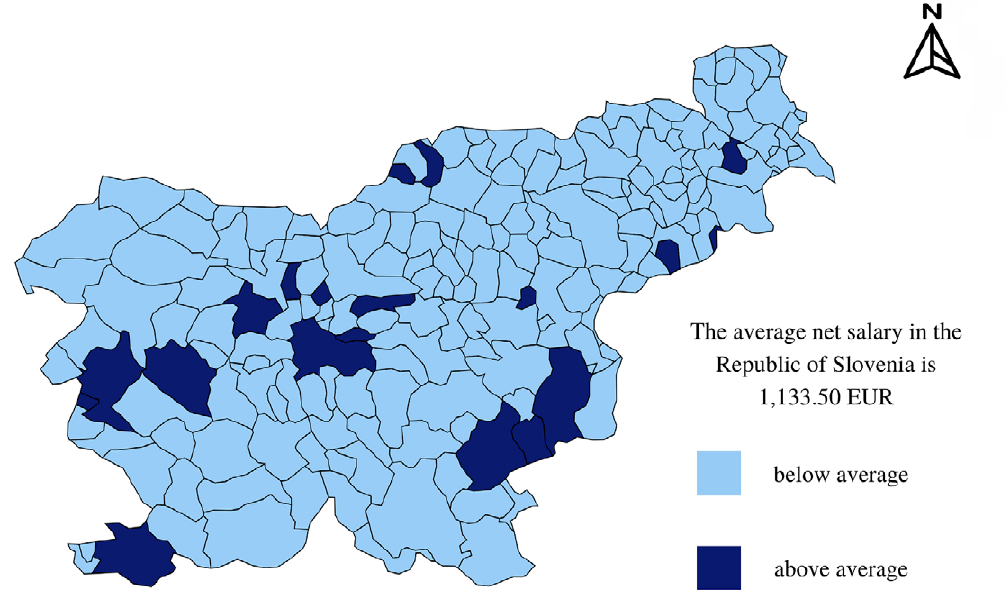
Figure 4. Average net salary in local self-governments in